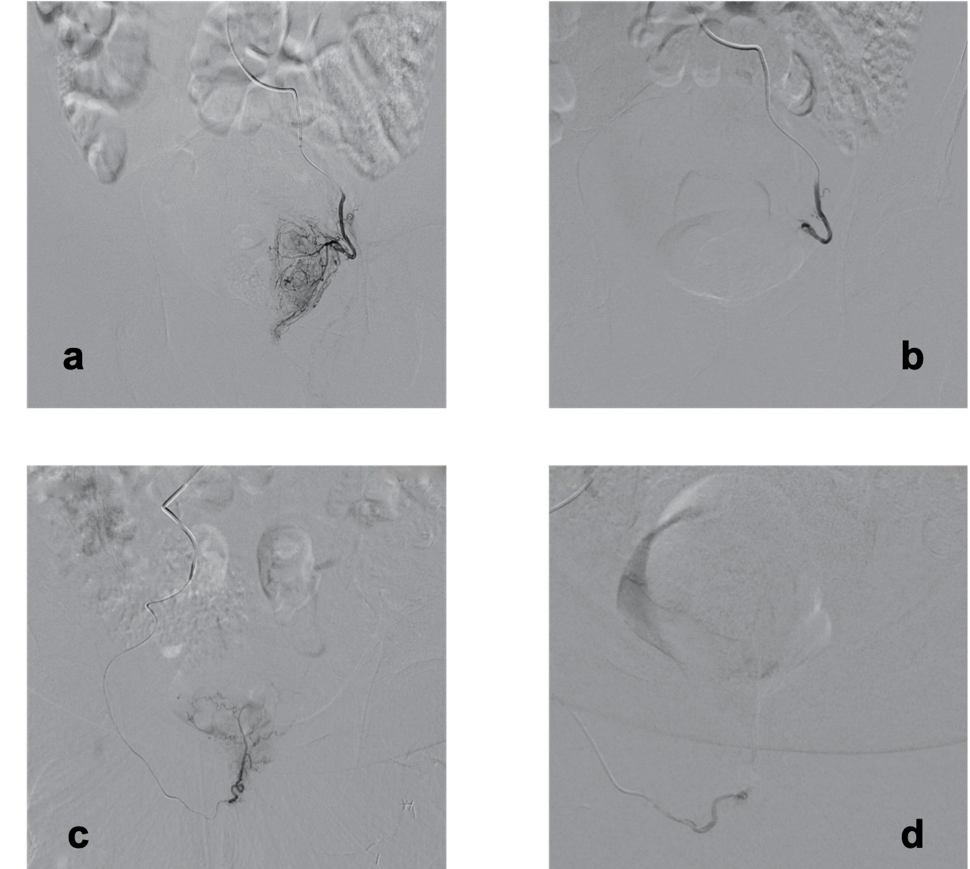
Figure 1. Selective prostatic artery angiograms during transradial prostatic artery embolization. All angiograms are performed on anteroposterior view. ( a ) Selective digital subtraction angiography of the left prostatic artery, showing a full uptake of the left hemi-prostate. ( b ) Selective digital subtraction angiography of the left prostatic artery following embolization, confirming complete stasis in the artery and disappearance of the uptake. ( c ) Selective digital subtraction angiography of an accessory right prostatic artery, arising from the distal part of the internal pudendal artery, and feeding both sides of the prostate. ( d ) Post-embolization selective digital subtraction angiography of the right accessory prostatic artery, confirming complete stasis and absence of uptake.